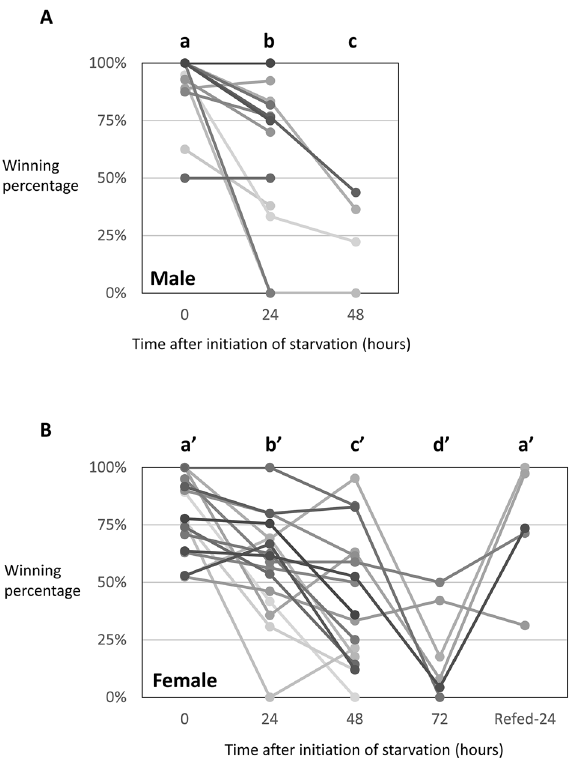
Figure 4. Starvation reduced the winning rate in S. detrahens . Matched and paired males ( A ) or females ( B ) were exposed to each other multiple times, and the winning rate in each contest was recorded (0 h). Then, the winners were starved, and the losers were continuously fed. At 24-h intervals after the initiation of starvation, the winning rates in the same pairs were measured. Fluctuations in the winning rates of the initial winner are shown by the single solid lines in the graphs. Breaks in the lines mean that measurement was not possible mostly because of death due to starvation. In the female pairs, at 72 h after the of initiation starvation, the initial winners were fed again to test the recovery of the winning rate, which was measured 24 h later. In each graph, time points labeled with different letters on the top (a, b, and c in graph ( A ) and a ′ , b ′ , c ′ and d ′ in graph ( B )) indicate significantly different winning percentages ( P < 0.05 after correction for multiple comparisons using the false discovery rate). The following analyses were conducted using R software version 4.0.2 59